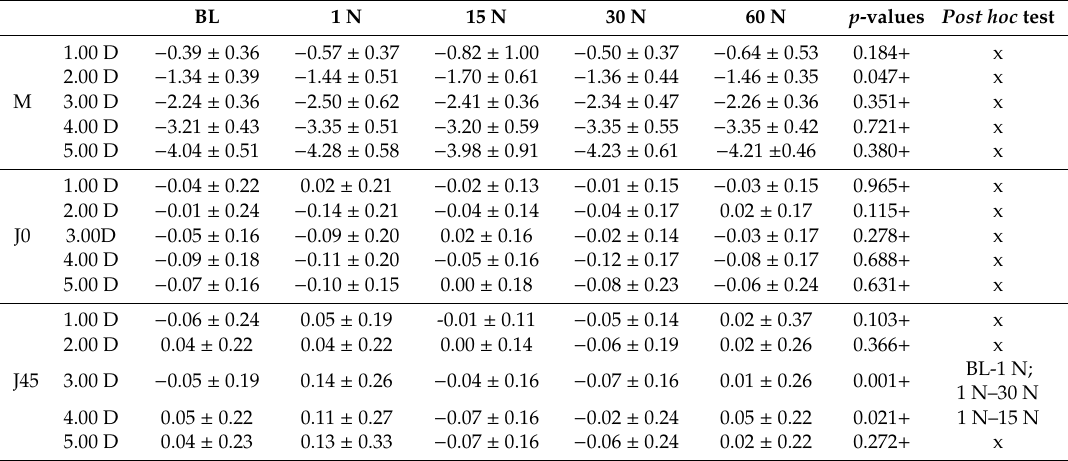
Table 3. Mean ± standard deviation of the accommodative response (M) and the variation of astigmatic components (J0 and J45) for each target